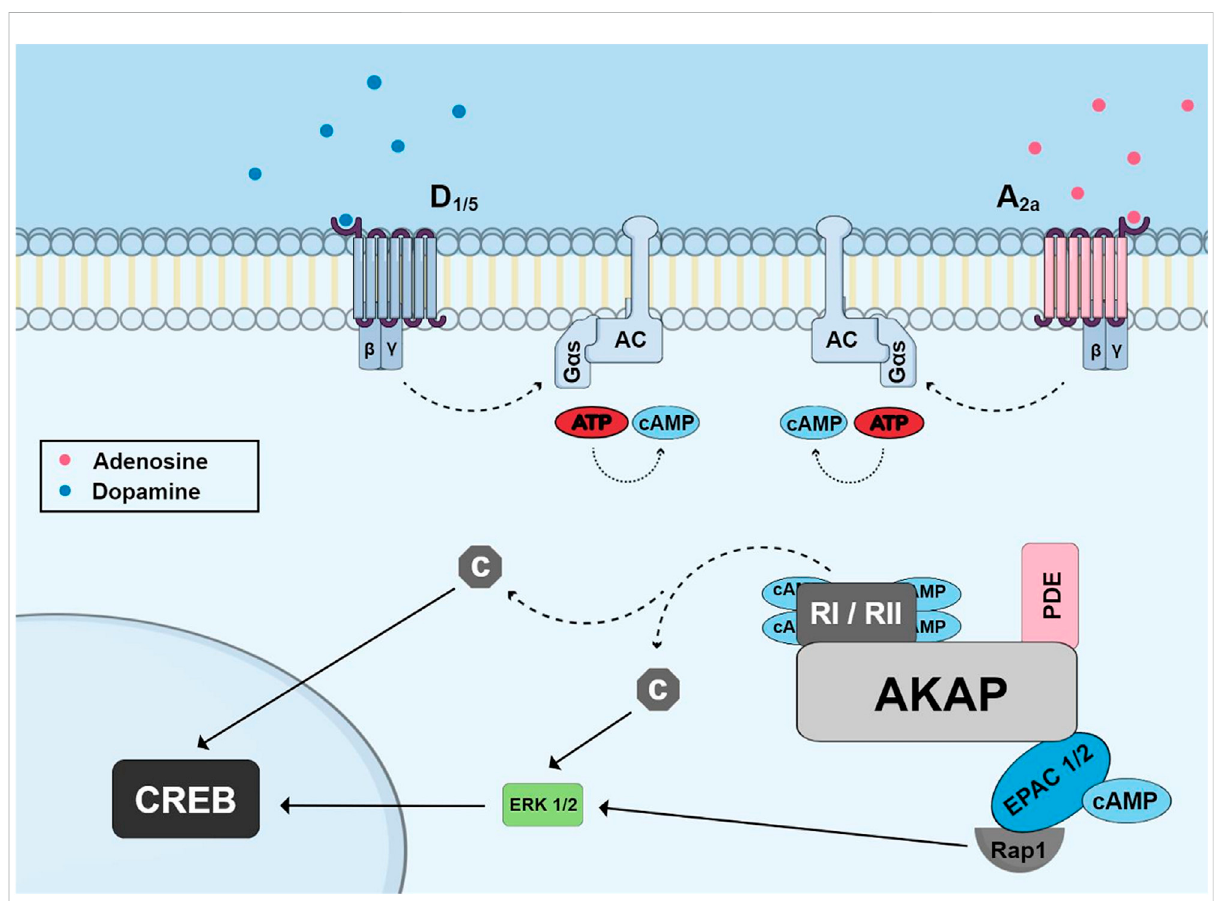
FIGURE 2 Schematic of cyclic AMP pathway to phosphorylate CREB showing accumulation of cyclic AMP induced by G-protein coupled receptors (dopamine and adenosine receptors) and highlighting the A-kinase Anchoring Protein (AKAP) and its binding sites for PKA regulatory subunits, phosphodiesterase and EPAC proteins. Dissociated catalytic PKA subunits or ERK (activated through EPAC and Rap1) can migrate to nucleus and phosphorylate